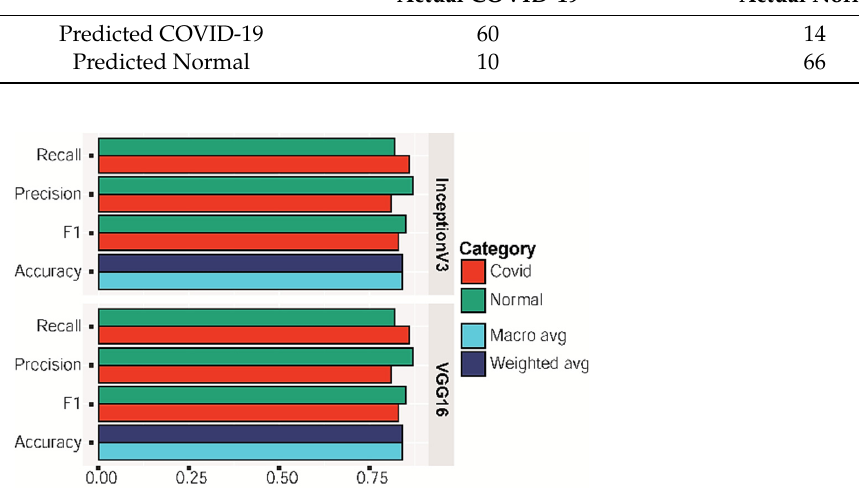
Figure 10. Precision, recall, F score and accuracy for VGG16 and Inception-v3 on chest CT